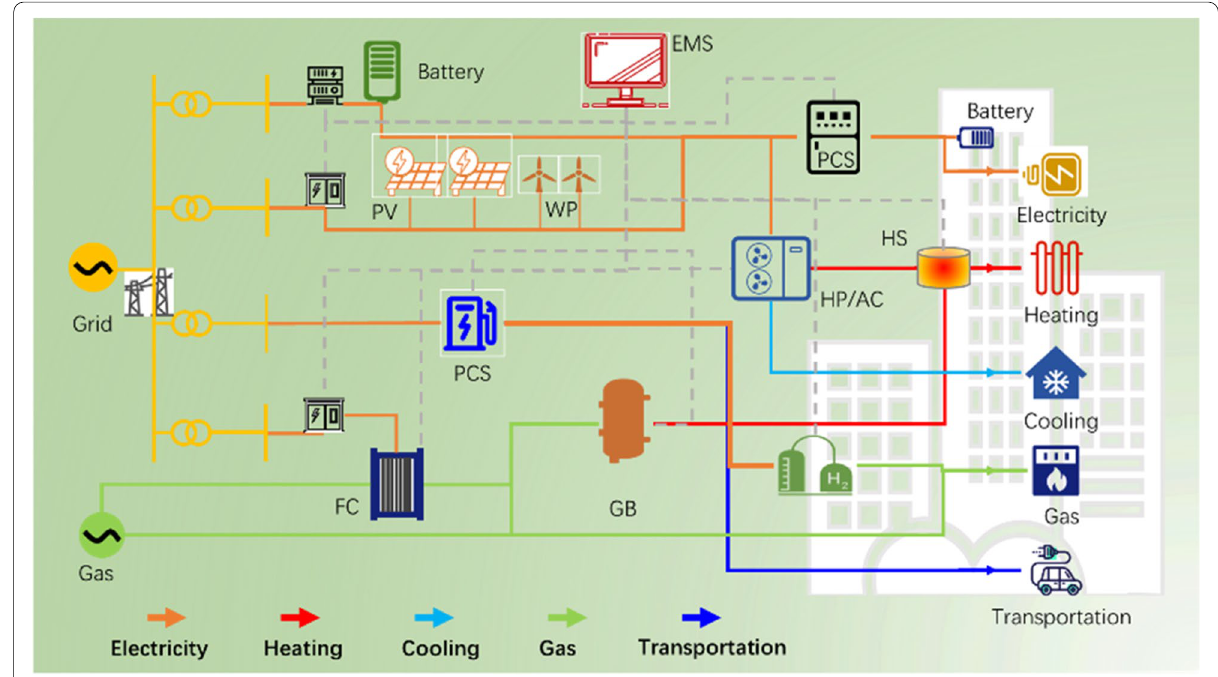
Fig. 5 Sketch of a distributed energy